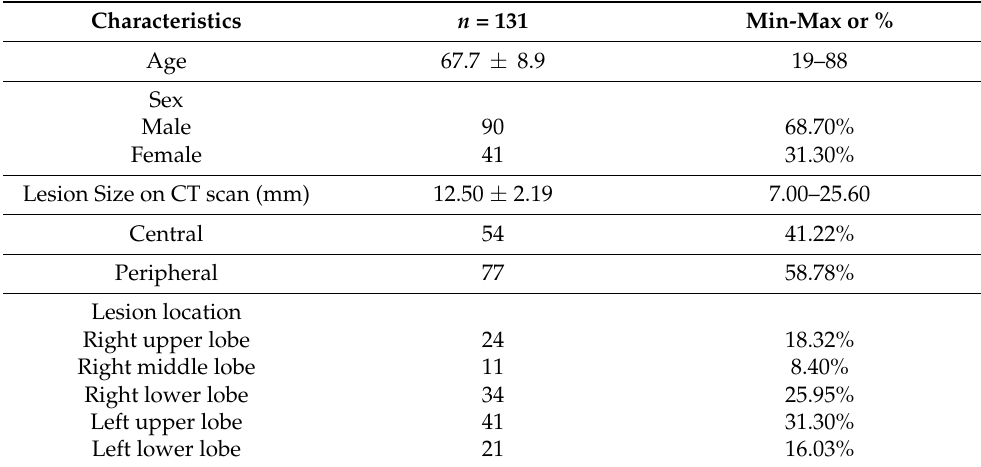
Table 2. Patients’ demographic characteristics and lesions’ characteristics on pre-operative Chest CT.